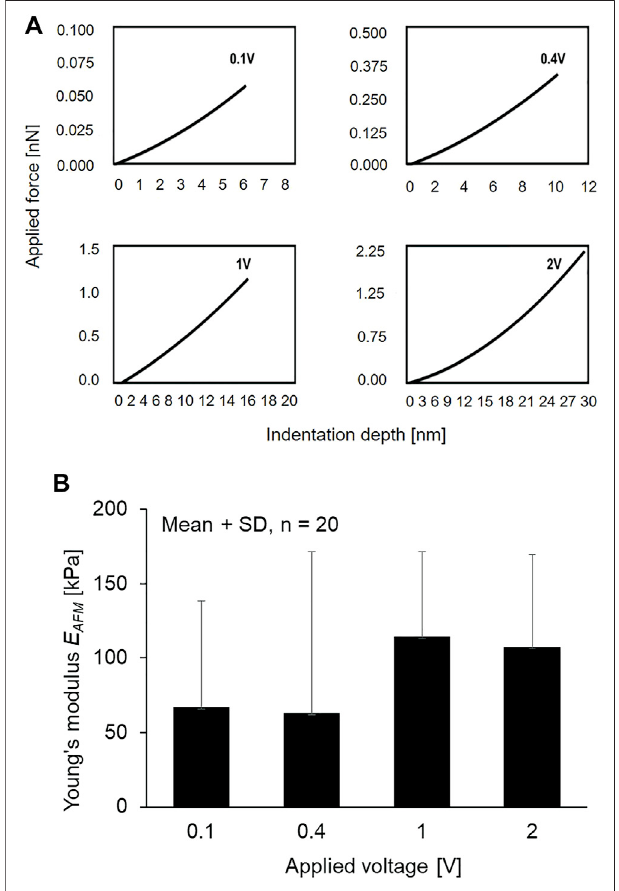
FIGURE8|(A) Relationshipofappliedvoltageandindentationdepth (B) The Young ’ s modulus of primary cilia at different applied